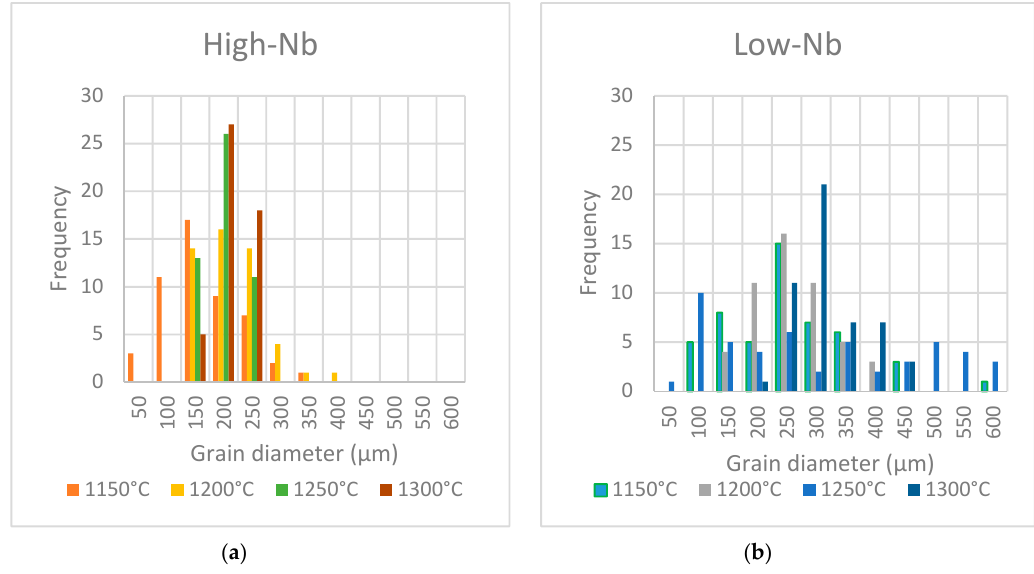
Figure 11. Grain size distribution of ( a ) high-Nb steel; and ( b ) Low-Nb steel.